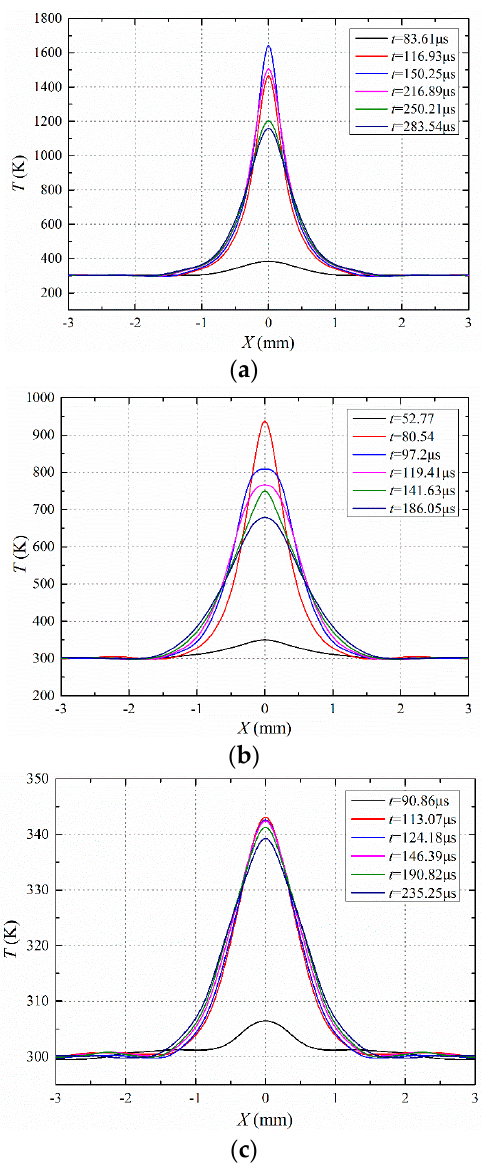
Figure 8. Temperature distribution: ( a ) cone terminal, radius of curvature = 2.5 mm; ( b ) cone terminal, radius of curvature = 5 mm; ( c ) spherical terminal, diameter = 40 mm.